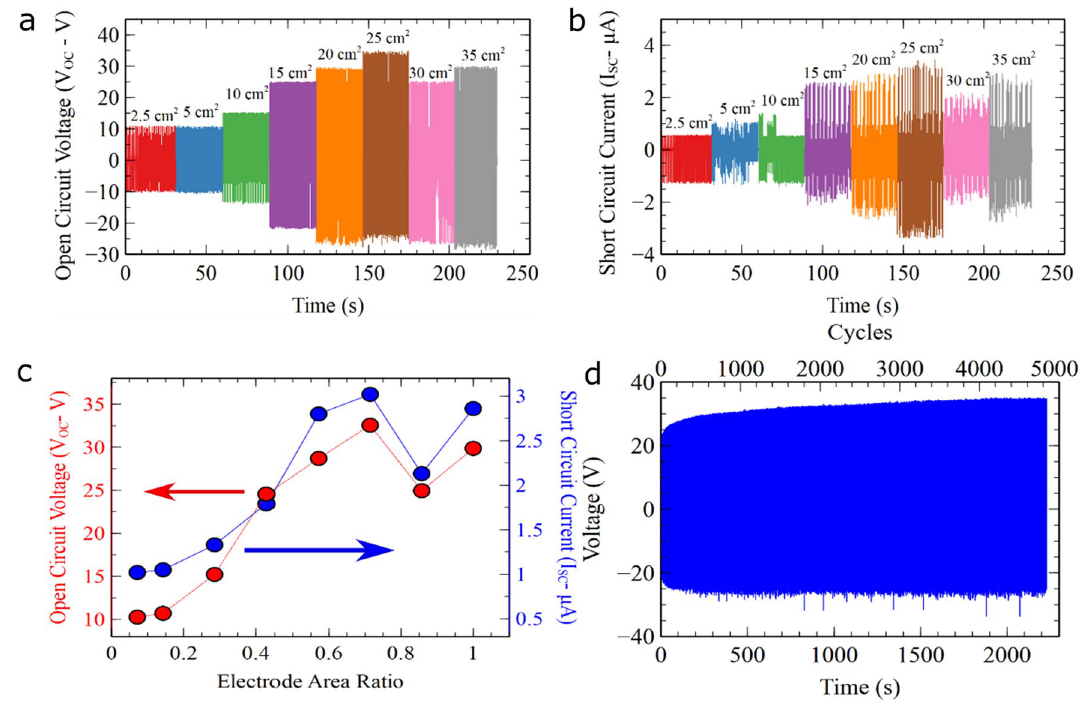
Fig. 4 a V and b I output profile for thick rubber-PVDF paper R-TENG as the area of one of the electrodes is increased while keeping oc sc another electrode area constant. c Average of maximum V OC (red) and I SC (blue) as the function of the ratio of electrode areas. d V OC output of Thick Rubber and PVDF Paper R-TENG for about 4800 cycles of